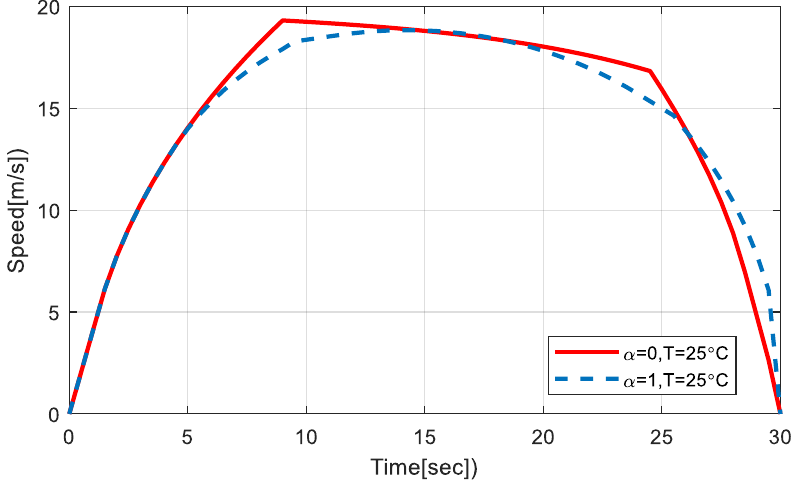
Figure 4. Comparison of speed trajectories under two cost functions ( α = 1 indicates that the battery life loss cost and the battery energy cost are comprehensively considered in the performance index; α = 0 means that only the battery energy cost is considered in the performance index).